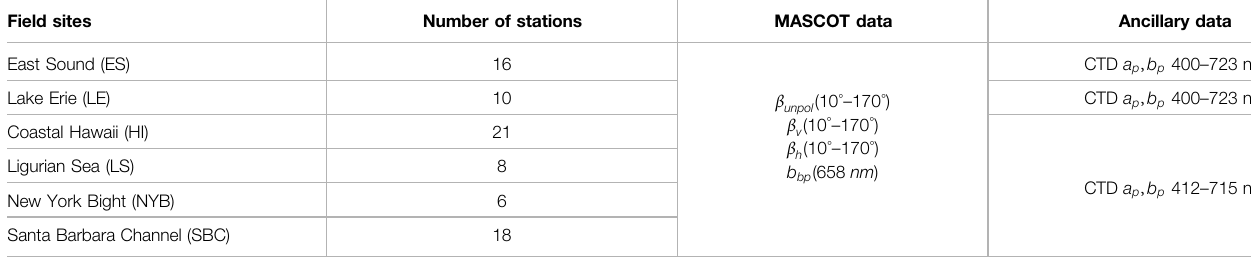
TABLE 1 | Field sites and data collected with the MASCOT device and ancillary